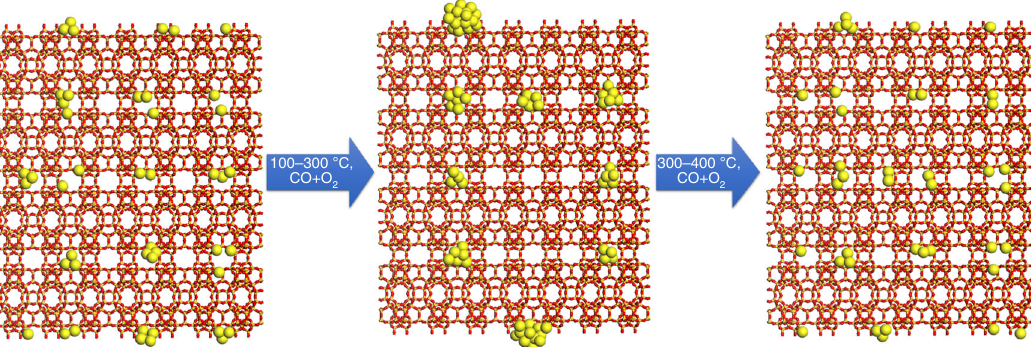
Fig. 4 Structural evolution of 0.17%Pt@MCM-22-300H 2 under CO + O 2 conditions. At 100 – 200 °C, highly dispersed Pt species will agglomerate into Pt clusters or even small nanoparticles. When the reaction temperature continues to increase to higher temperature (300 – 400 °C), Pt nanoparticles will disintegrate and form highly dispersed Pt species and Pt